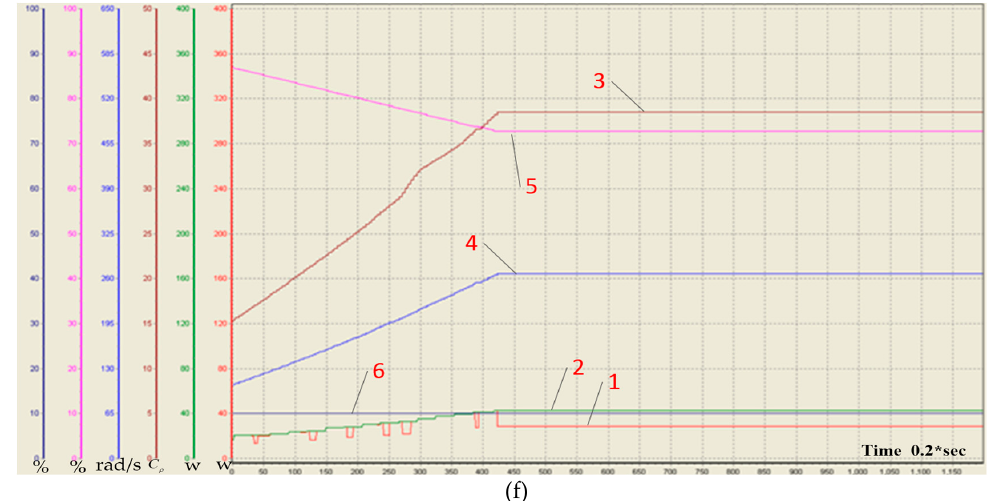
Figure 11. The tendency chart of relevant data in PWECS: ( a ), ( c ) and ( e ) are the variable hill-climbing when the speed of the wind at 15 m/s, 10 m/s and 7 m/s; ( b ), ( d ) and ( f ) are the uniform hill-climbing when the speed of the wind is at 15 m/s, 10 m/s and 7 m/s.